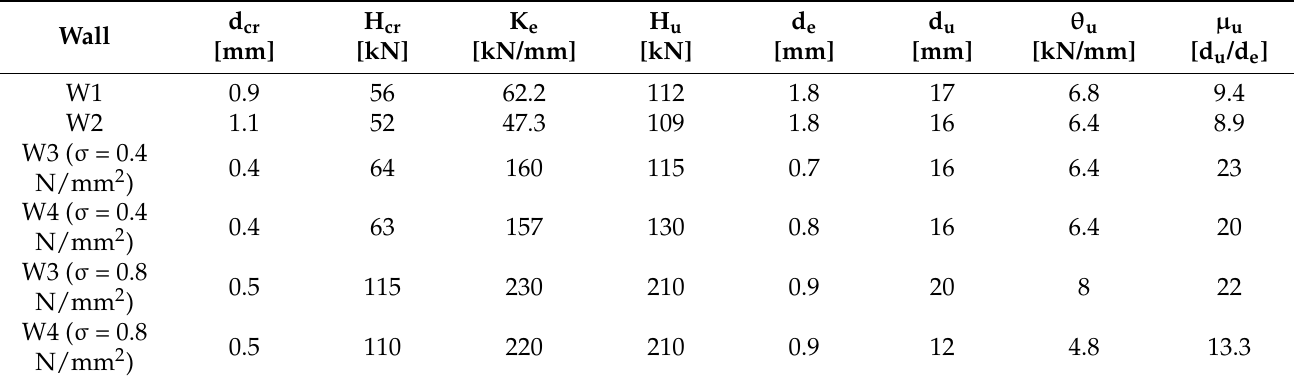
Table 13. Results of bilinear idealization for the tested